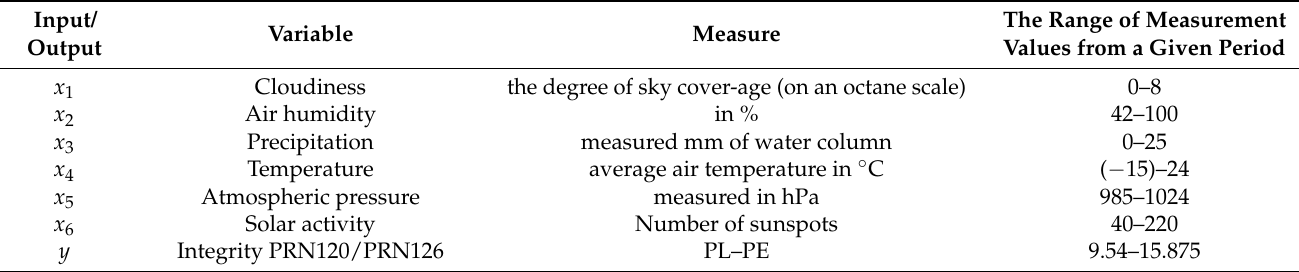
Table 2. Definition of explanatory (input) and explained (output) variables and their measure.